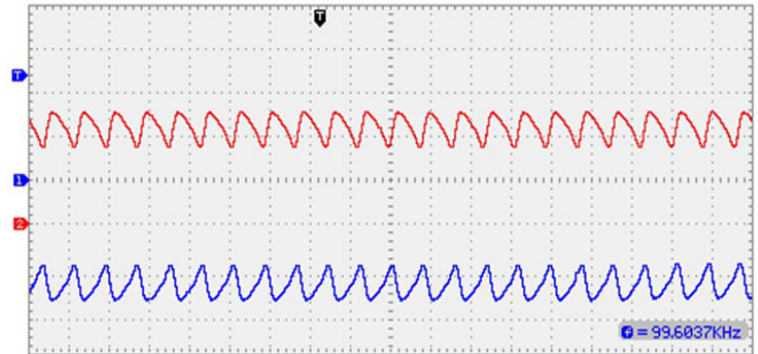
Figure 19. Capacitor voltages V C 3 ( top ) and V C 4 ( bottom ) (vertical scale 150 V/div).